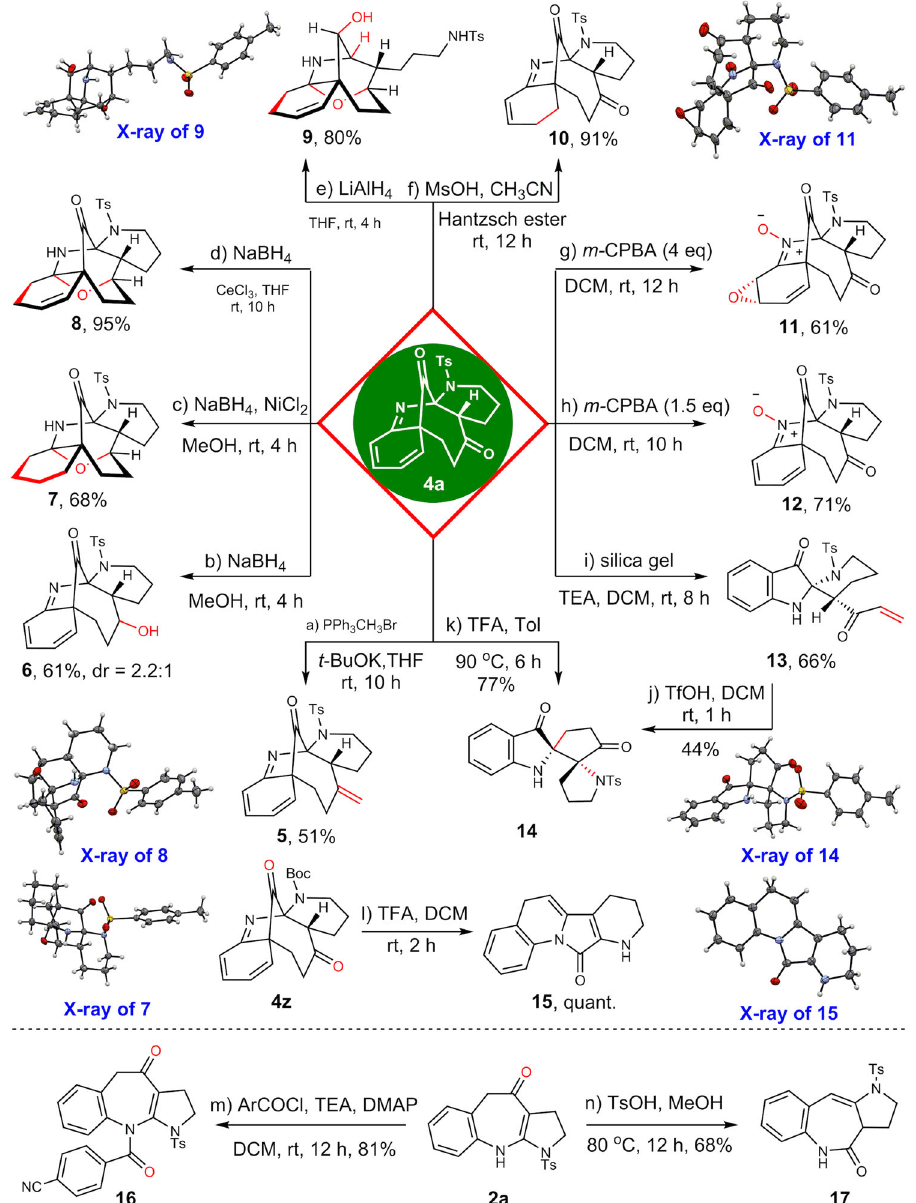
Fig.8|Late-stagediversi fi cationof4aand2a. Selectiveole fi nationandreduction of the dione to give 5 and 6 . Reductive acetalation companied with entirely reduction of the diene to afford the cage product 7 . Luche reduction conditions could also produce the cage product 8 with the cyclohexadiene partially hydro- genated. The bridged carbonyl group could be reduced with lithium